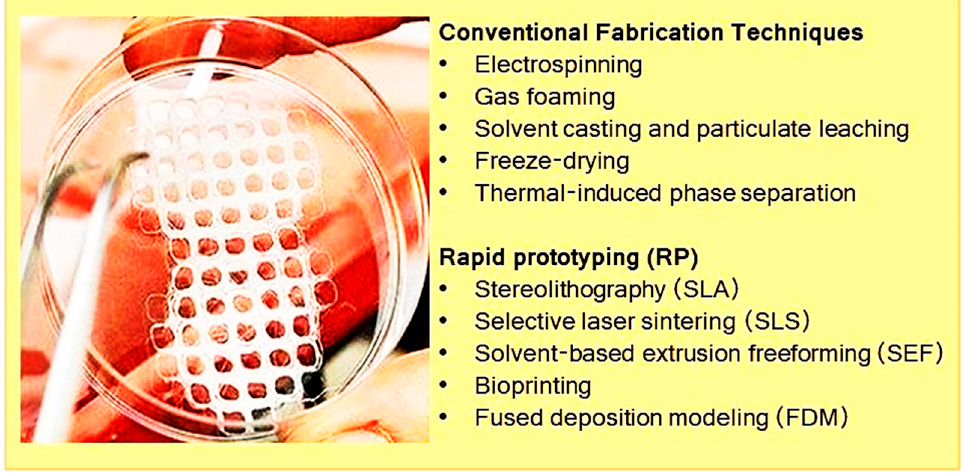
Figure 5. Different fabrication methods for producing scaffolds. Figure 5. Di ff erent fabrication methods for producing sca ff